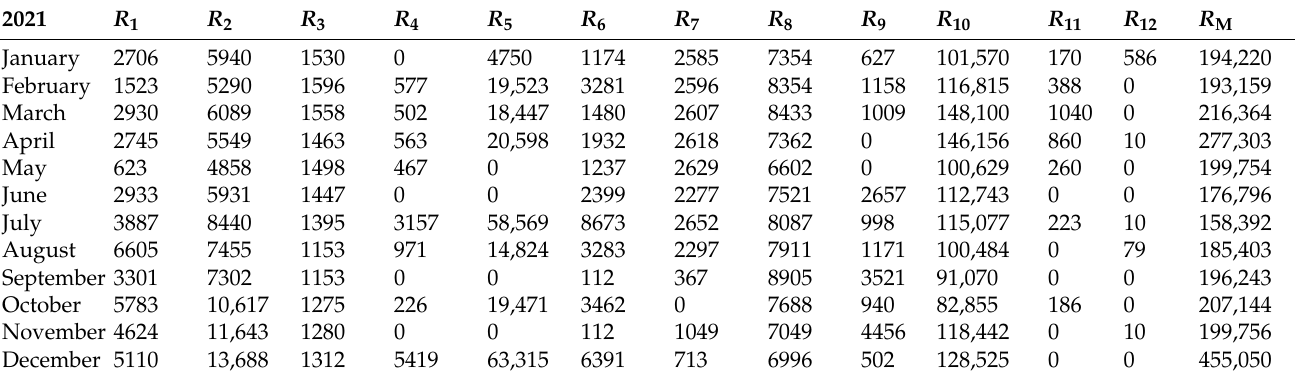
Table 2. Illustration of the real disbursement and income data.